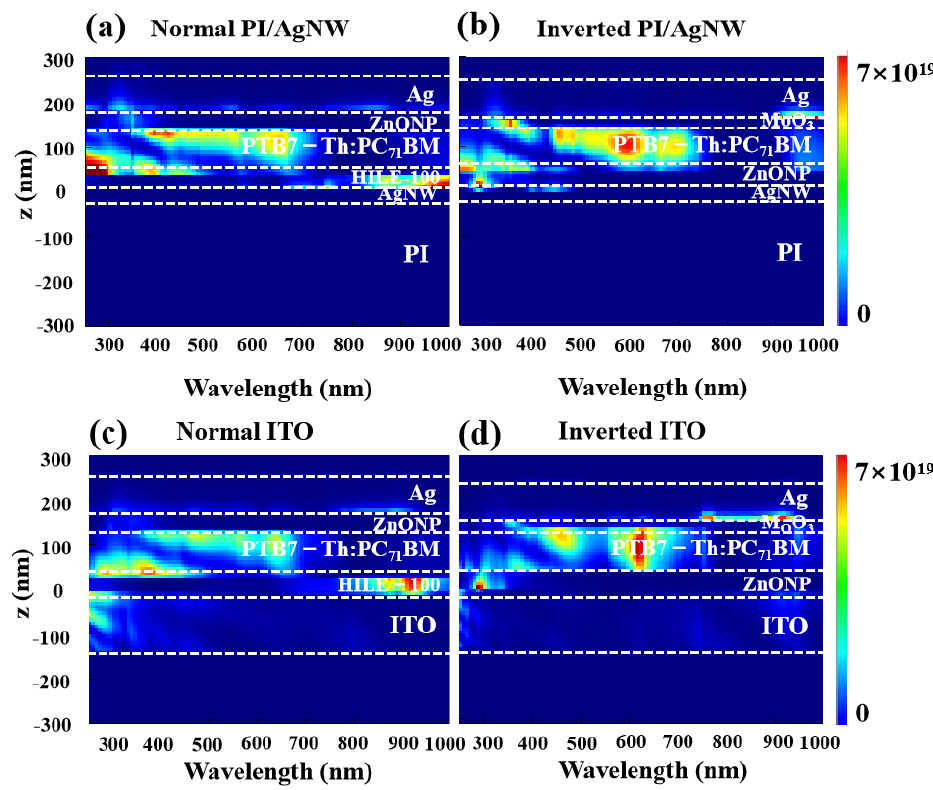
Figure 2. Full-wavelength absorbed power spectra of ( a ) normal (S1), ( b ) inverted (S2) PI/AgNW based devices compared with ( c ) normal (S3) and ( d ) inverted (S4) ITO based devices. As energy level matching is another important factor affecting device performance, we tested the work function of AgNW and the energy levels of ZnONP. As shown in Figure 3a, based on the threshold value of Ecutoff which corresponds to the cut-off edge of secondary electron emission in UPS, the work functions ( Φ ) of ZnONP and AgNW films can be calculated via the formula of Φ = h v − E cutoff , where h v is 21.22 eV for a He I photon source. Therefore, the work function of AgNW is determined as 4.17 eV. Moreover, as shown in Figure 3b, the energy difference between the Fermi level (E f ) of ZnONP and the value of the valence band maximum (VBM) is 2.55 eV by linear extrapolation, determining the VBM of ZnONP to 6.8 eV, which is close to the value reported in the literature [41]. The deep VBM of ZnONP can effectively prevent holes from entering the cathode, which is beneficial to reduce carrier recombination at the AgNW cathode. To further calculate the conduction band minimum (CBM) of ZnONP, the absorption spectrum of ZnONP was measured (Figure 3c), determining the CBM of ZnONP to be 3.62 eV. As shown in Figure 3d, the electron injection barrier (0.55 eV) between AgNW and ZnONP is much smaller than that (1.03 eV) between AgNW and HIL E-100, indicating PI/AgNW is more suitable to be a cathode TCE in flexible OSCs